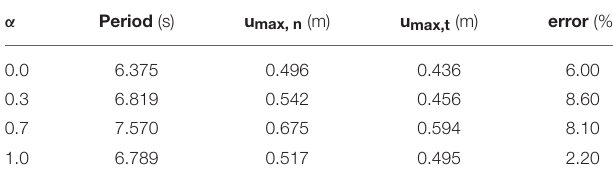
TABLE 1 | Comparison of numerical and analytical